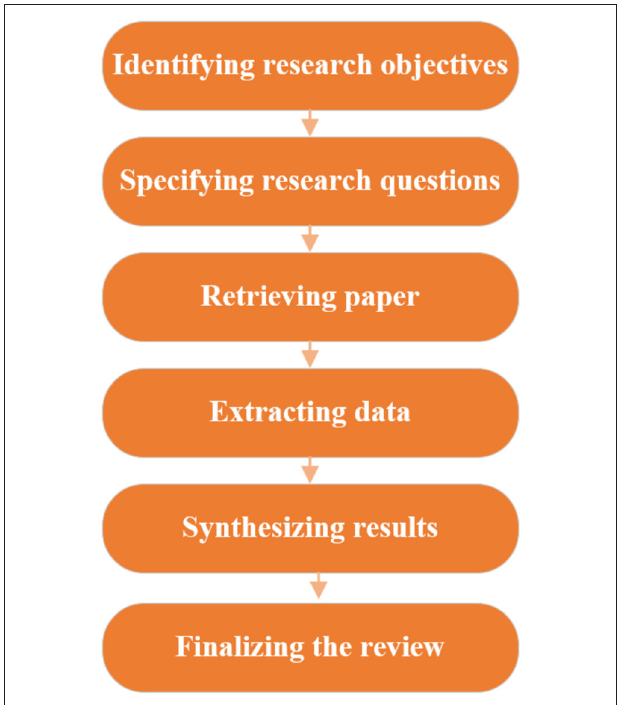
FIGURE 1 | Procedures to conduct this